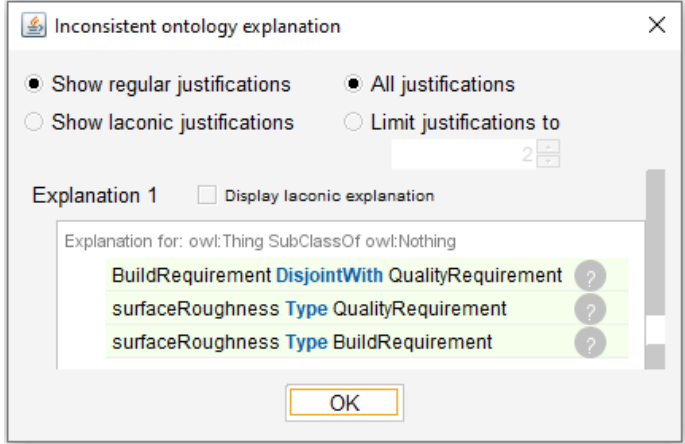
Figure 14. Example of consistency checking of the